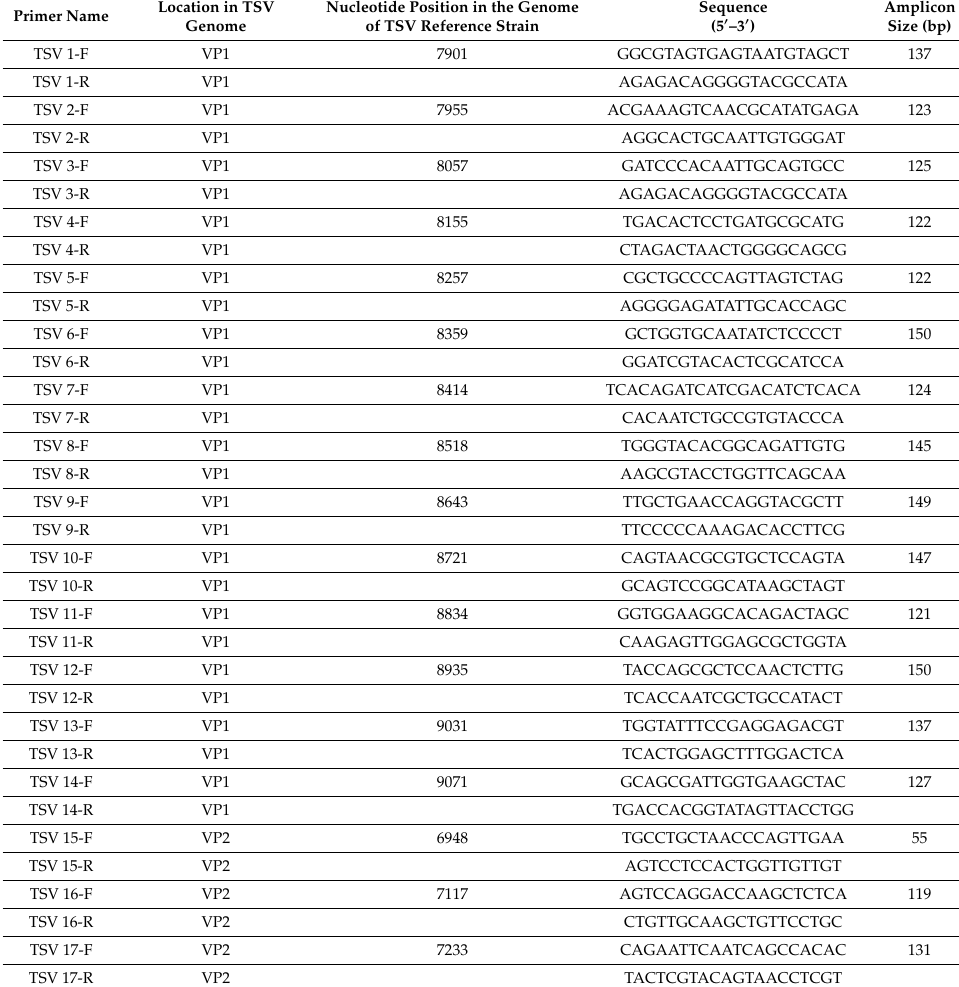
Table 2. A summary of Taura syndrome virus (TSV)-specific primers. Primers for this study were designed based on the TSV reference genome (NC_003005) to amplify TSV using RNA isolated from DFPE tissue. The World Organization for Animal Health (OIE)-recommended primers to amplify TSV through RT-PCR and RT-qPCR are listed for